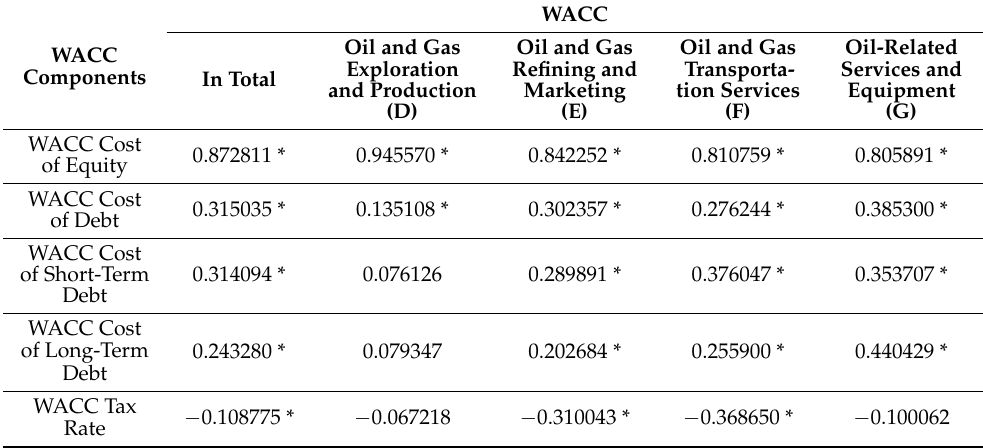
Table 8. Summary statistics correlation matrix for WACC with group